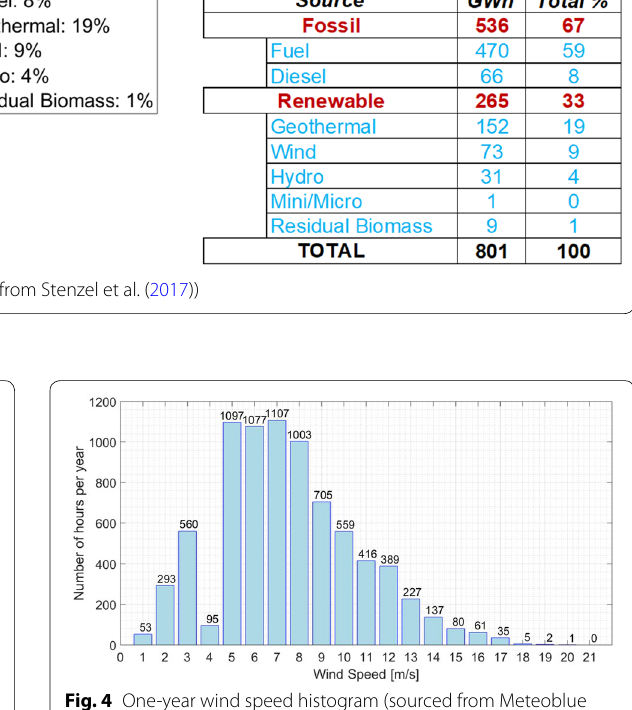
Fig. 4 One-year wind speed histogram (sourced from Meteoblue